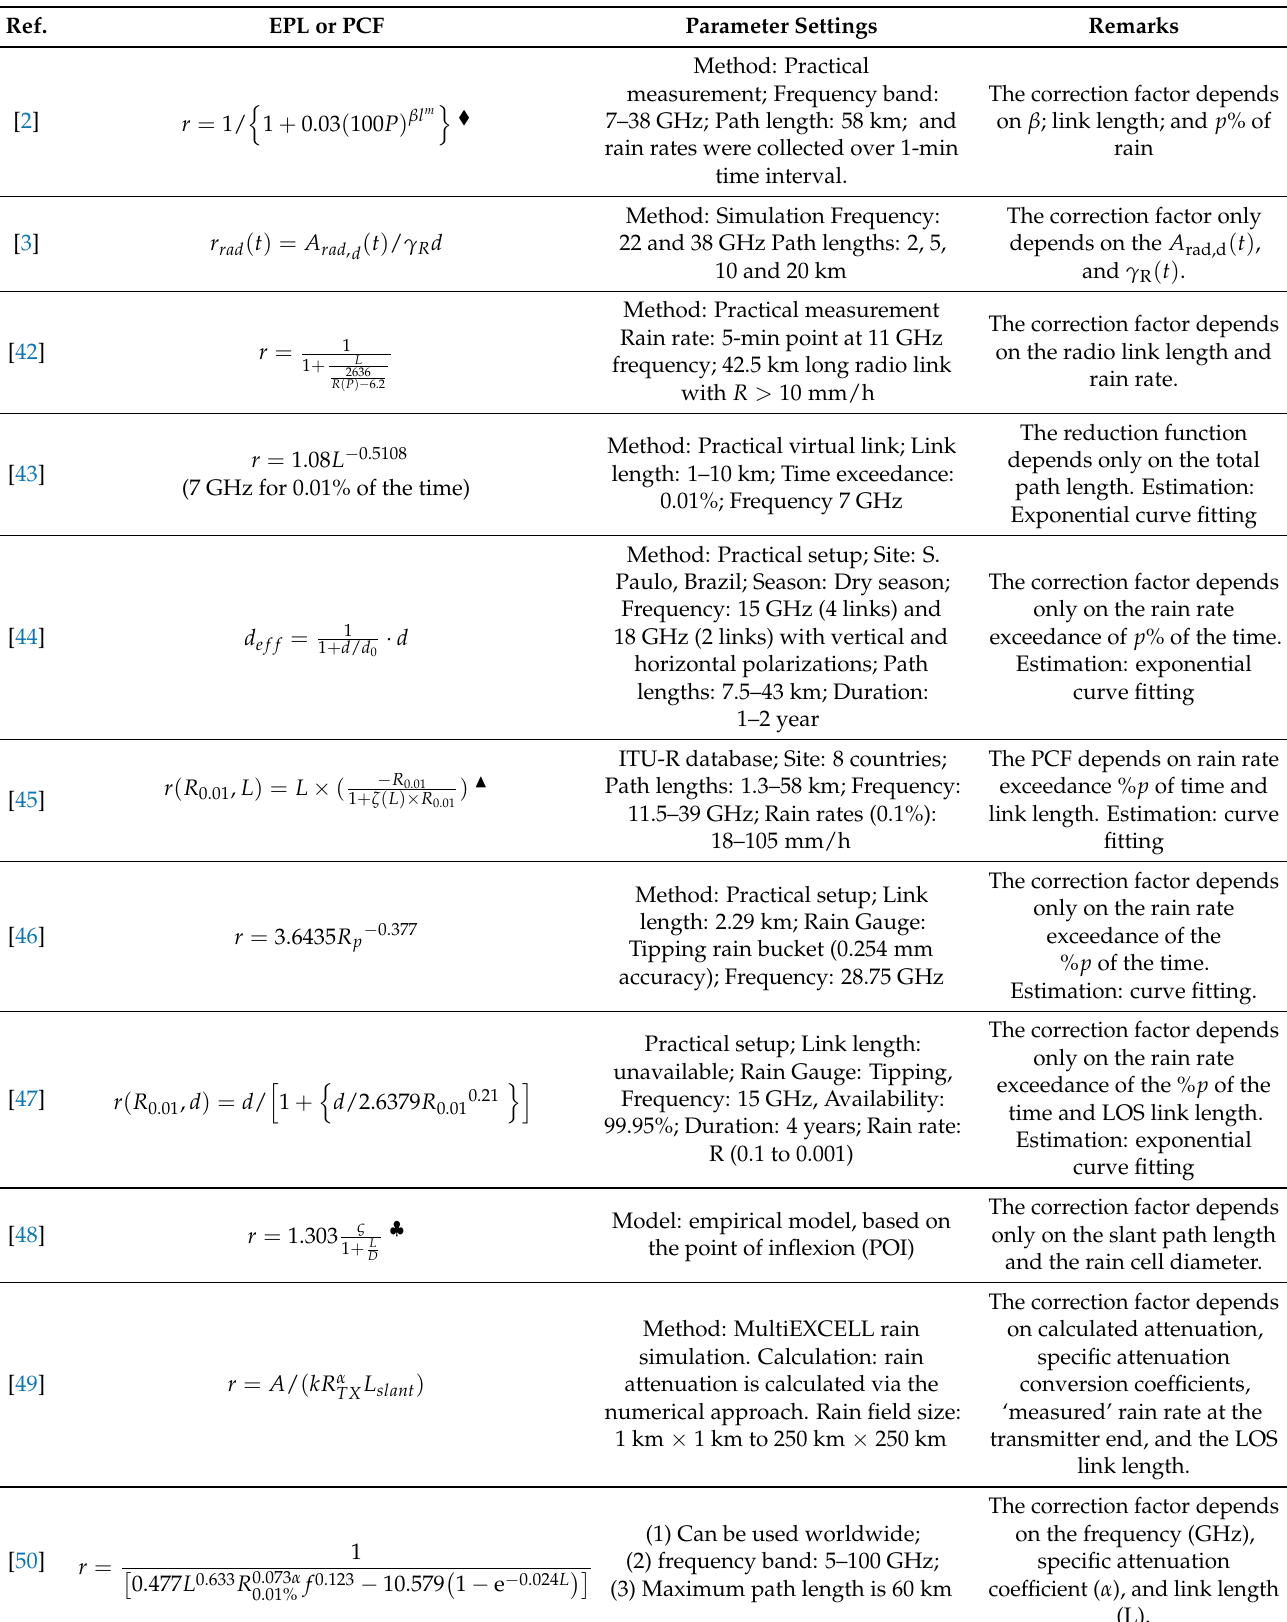
Table 3. Techniques to calculate effective path length (EPL) or path length coefficient factor (PCF).